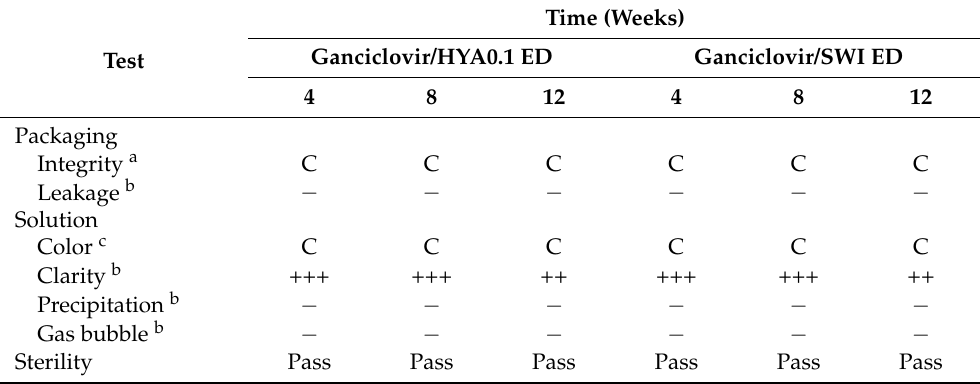
Table 6. Appearance and sterility results of ganciclovir/HYA0.1 ED and ganciclovir/SWI ED after storage at 30 ± 2 ◦ C for 12 weeks. Time (Weeks) Ganciclovir/HYA0.1 ED Ganciclovir/SWI ED Test 4